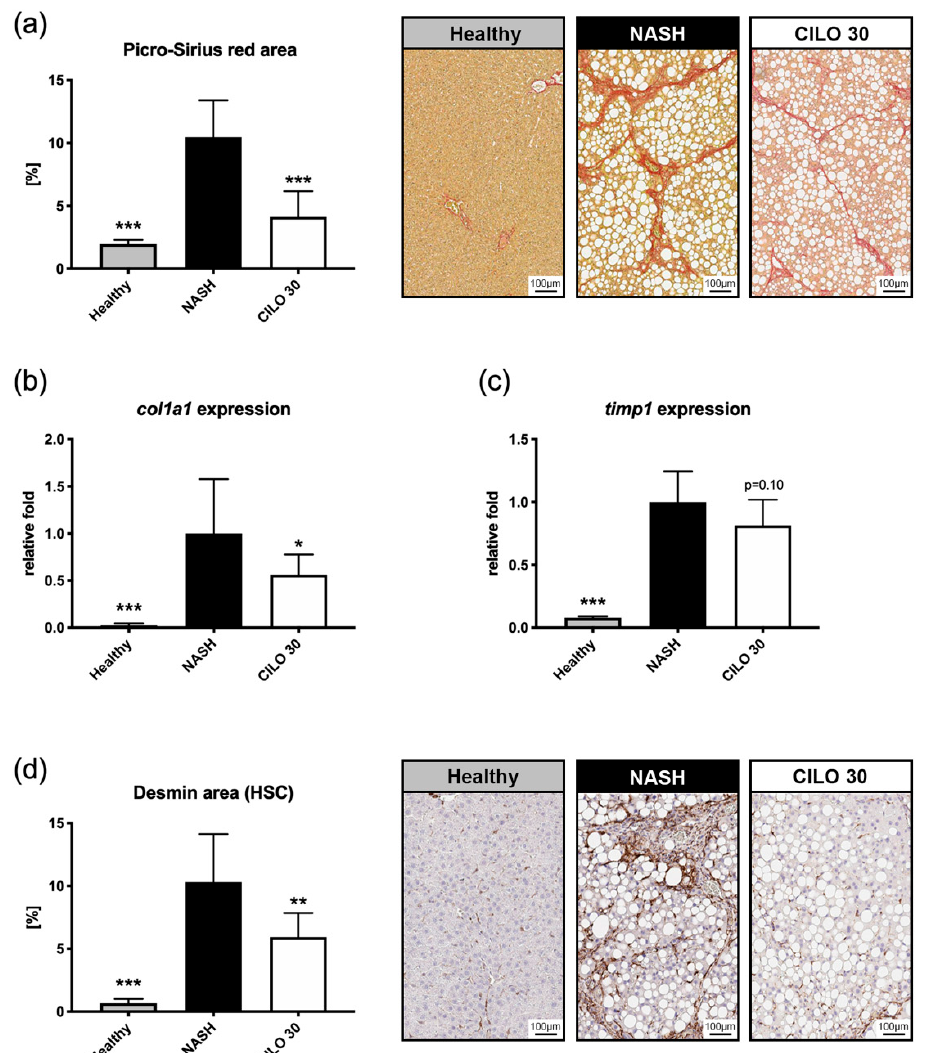
Figure 3. Cilofexor decreases liver fibrosis and hepatic stellate cell activation. ( a ) In the prolonged NASH model, the decrease of Picro-Sirius red area in cilofexor (CILO) treated rats was confirmed. ( b ) In NASH rats receiving cilofexor, hepatic col1a1 expression was nearly halved by cilofexor treatment and also ( c ) a trend towards reduced timp1 expression was notable. ( d ) Desmin, a marker of hepatic stellate cell activation, was detected using immunohistochemistry. In cilofexor-treated animals, a significant reduction of desmin area was evident. * p < 0.05, ** p < 0.01, *** p < 0.001 vs. NASH (14-week model); two-sided unpaired t -test; n = 7–9 per group.